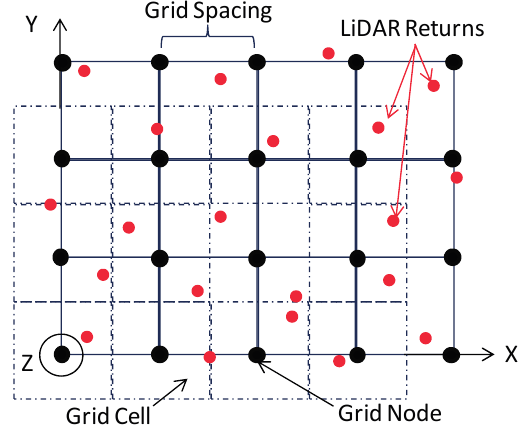
Figure 20. Creation of surface elevation model via interpolation.